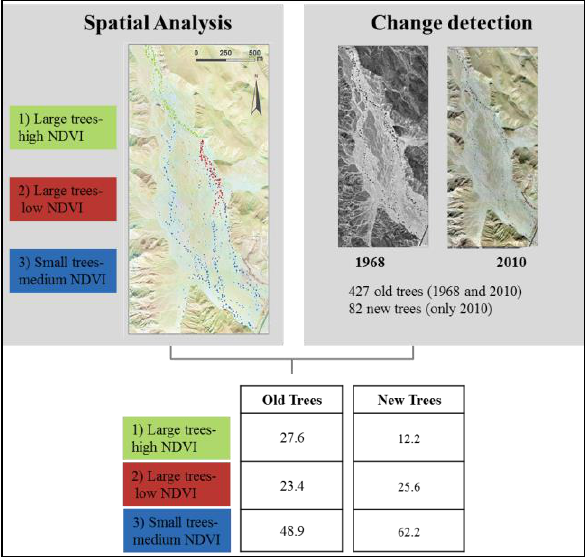
Figure 4. Outline of the spatial analysis and change detection integration technique and